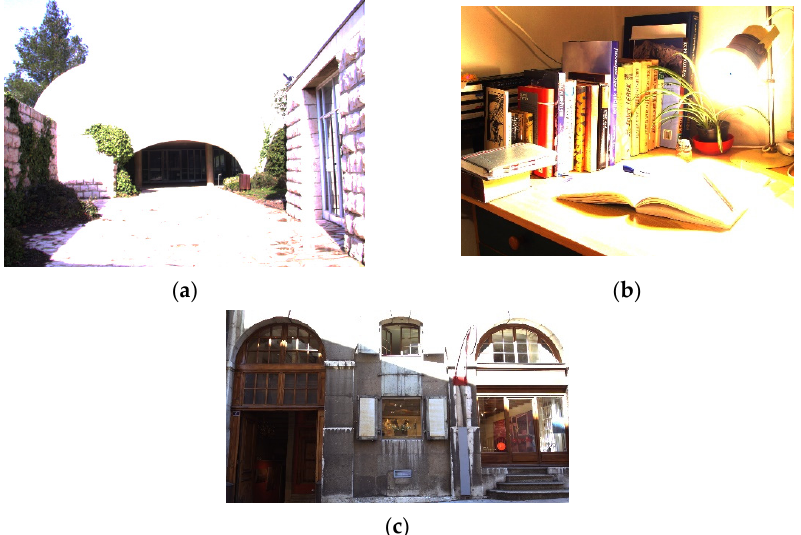
Figure 6. Baseline LDR images (processed using a simple linear compression), which illustrate the difficulty of photographic reproduction and can be compared with the results shown in Figures